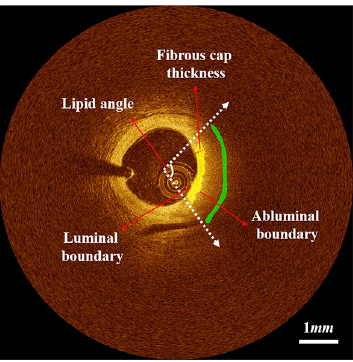
Figure 2. Representative case of lipid and fibrous cap annotations with quantitative measurements: lipid angle and fibrous cap thickness. Green and yellow are lipid and fibrous cap, respectively. The luminal boundary perfectly matches to the lumen boundary, and the abluminal boundary is defined as the inner border of the lipid pool. Lipid annotations were 50 pixels away from the lumen boundary with a ribbon of 20 pixels wide in ( r,θ ) domain. Colors are green (lipid plaque) and yellow (fibrous